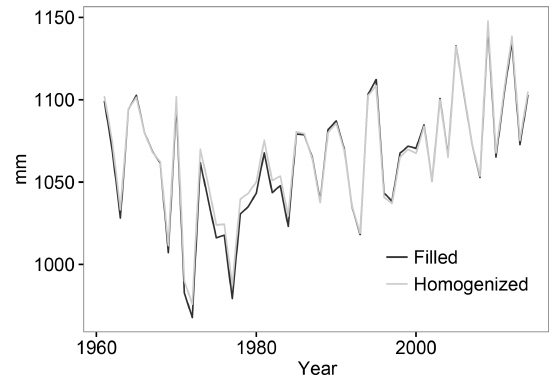
Figure 7. Temporal evolution of the mean regional values of ET o before (filled) and after (homogenized)